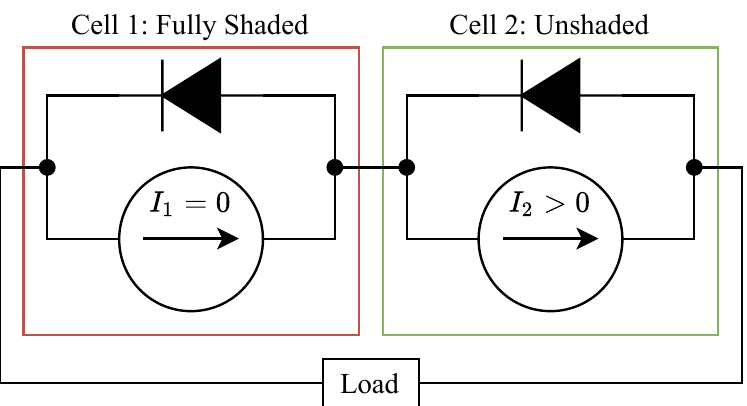
Figure 1. Dilemma of two PV cells with differing solar irradiance represented by the simplest PV cell model.